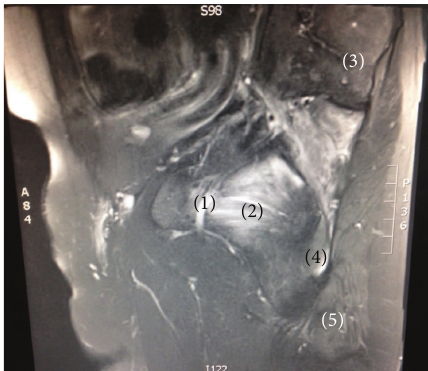
Figure 3: Oblique parasagittal section of T2-weighted MRI display- ing passage of the right sciatic nerve above the piriformis muscle. (1) Sciatic nerve. (2) Piriformis. (3) Sacroiliac joint. (4) Ischium. (5) Ischial